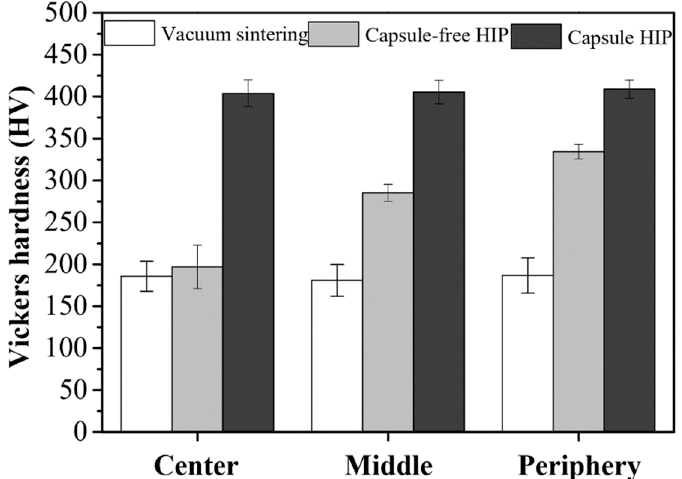
Figure 9. Vickers hardness of Ti6Al4V alloy sintered by different sintering techniques versus different positions of the specimens.